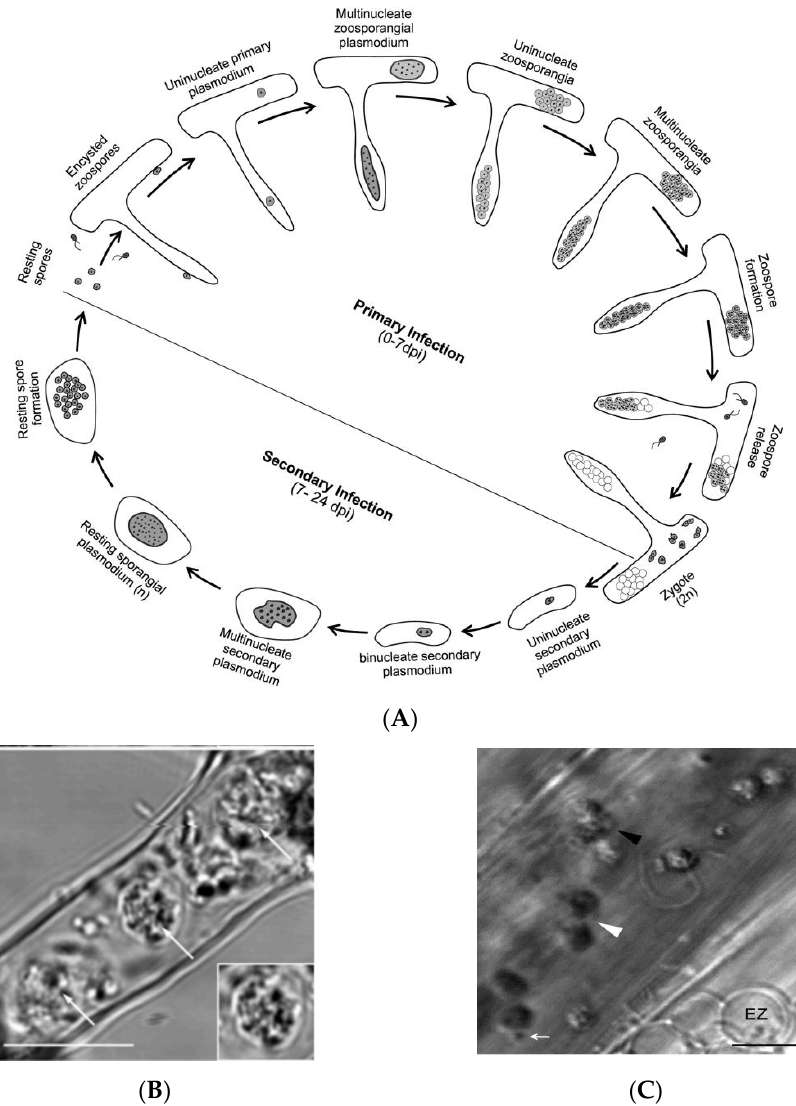
Figure 2. Diagram of the refined life cycle of Plasmodiophora brassicae ( Reprinted with permission from Ref. [Liu et al 2020]. 2020, Liu, L.J.; Qin, L.; Zhou, Z.; Hendriks, W.; Liu, S.; Wei, Y.) ( A ) Complete life cycle of Plasmodiophra brassicae ; ( B ) primary zoospore in root epidermis (white arrows); ( C ) secondary zoospore (white arrowhead) and a fusion of two zoospores to form a zygote (black arrowhead).